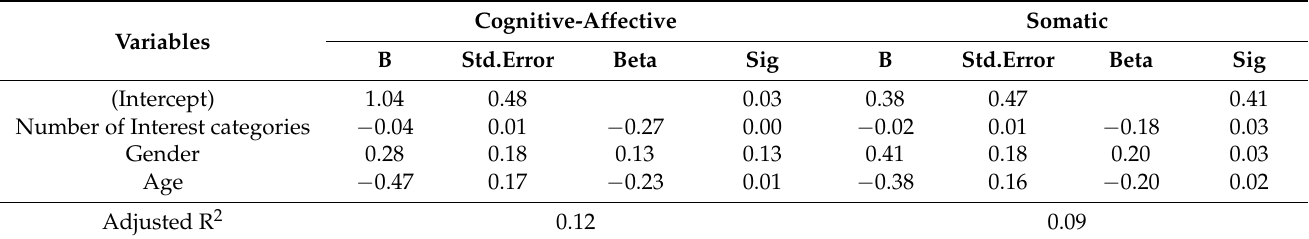
Table 7. Linear Regression models. Interest categories. Base model.